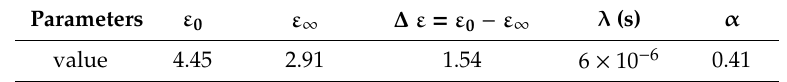
Table 1. Optimum values of Cole–Cole formula for GO/PDPA sheet composites-based ER fluid.